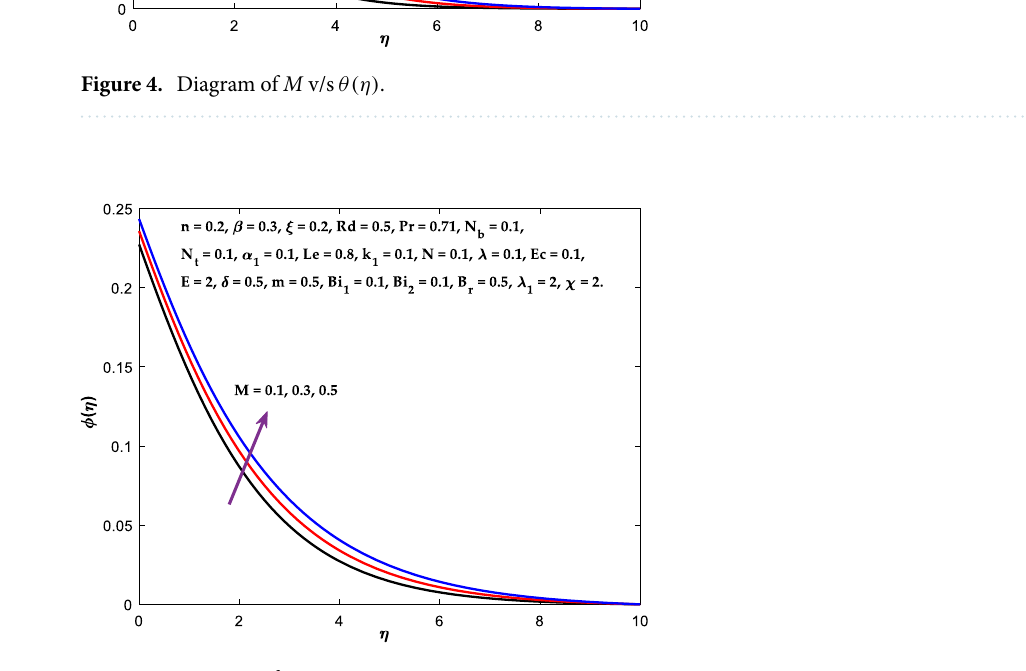
Figure 5. Diagram of M v/s φ(η)